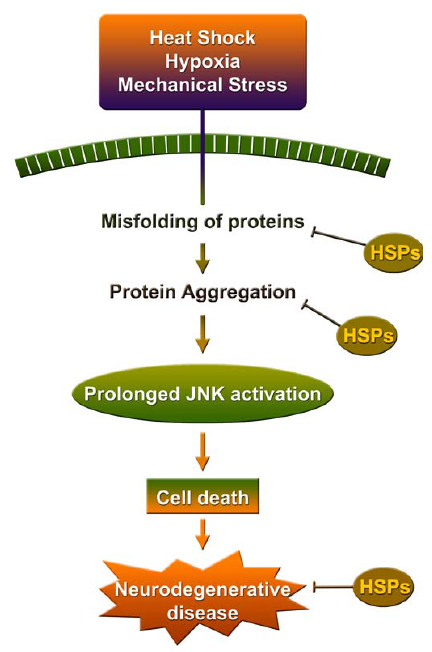
FIGURE 1. Misfolded proteins and neurodegenerative disorders. External stresses, such as heat shock, hypoxia, and mechanical stress, induce the production of reactive oxygen species and denaturation of cellular proteins. Moderated stress on the cell system induces HSP expression. These HSPs are capable of ensuring proper folding or treatment of misfolded proteins, as well as inhibiting protein aggregation, thus preventing neurodegenerative diseases that result from high stress–induced cell